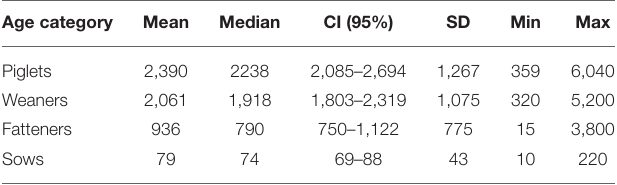
TABLE 2 | Descriptive statistics on the distribution of different age categories on the study farms measured as number of pigs kept (sows) and number of produced pigs per year (piglets, weaners, and fatteners) on 71 farrow-to-finish pig farms in Switzerland in 2017.